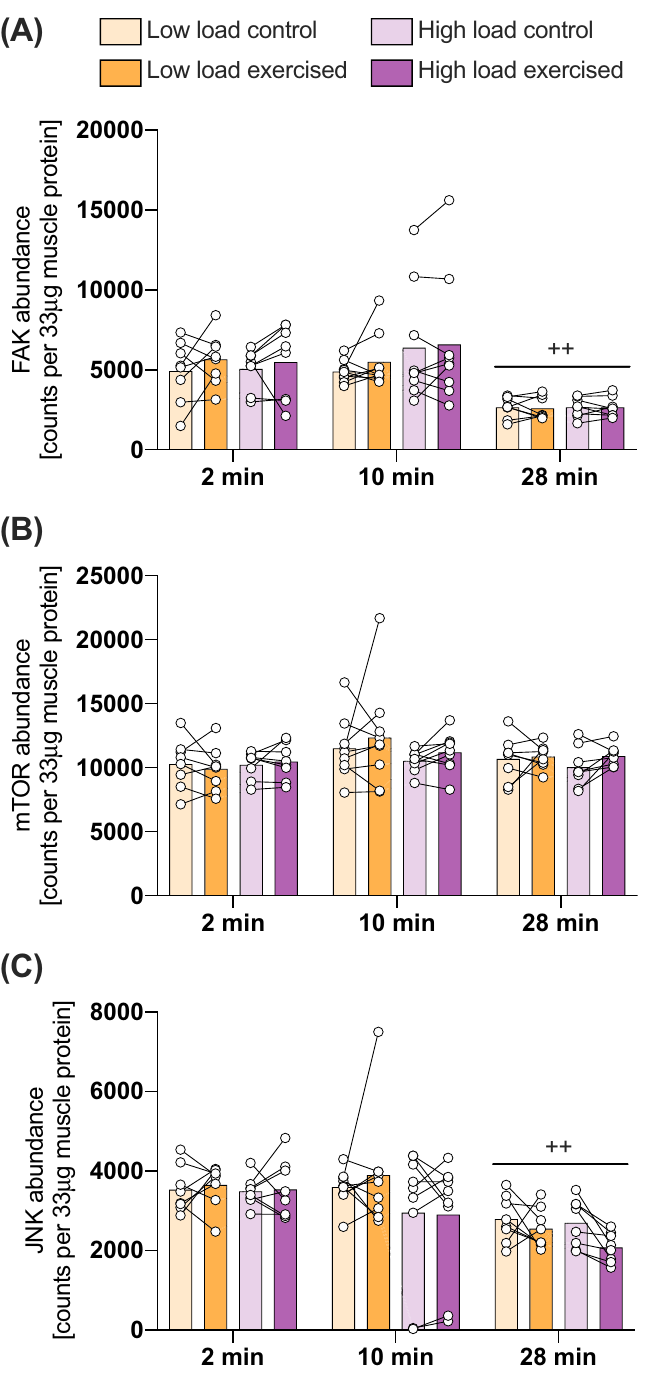
Figure 4. FAK and JNK abundance is decreased with exercise duration in both exercised and contralateral control leg, but not by exercise nor load per se. Kinase abundance of FAK ( a ), mTOR ( b ) and JNK ( c ) as measured in 33 µg soluble protein from exercised and contralateral control TA muscles after 2, 10 and 28 min of exercise with a high or a low load. Post-hoc significant differences denoted with ++ p < 0.01 versus 2- and 10-min exercise irrespective of group. Data are presented as individual muscle values (circles), contralateral comparisons (lines) and group means (bars) (n = 8 per group for the 2 min and 28 min protocol, n = 9 per group for the 10 min